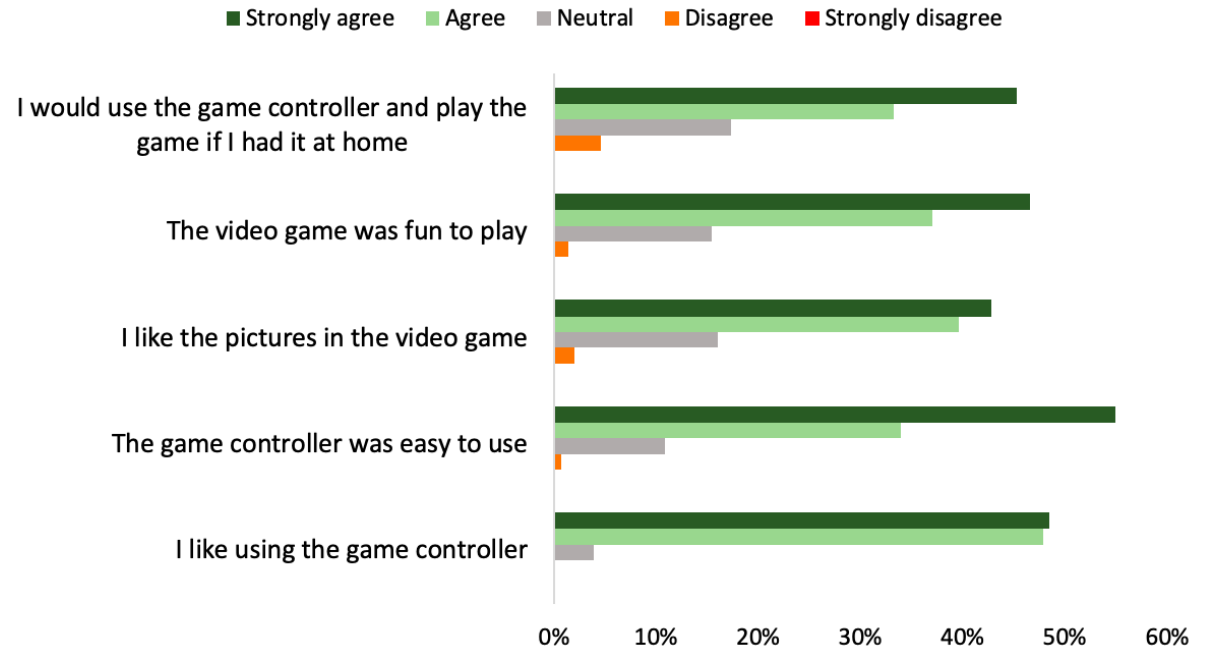
Figure 4. Game appreciation as reported by the